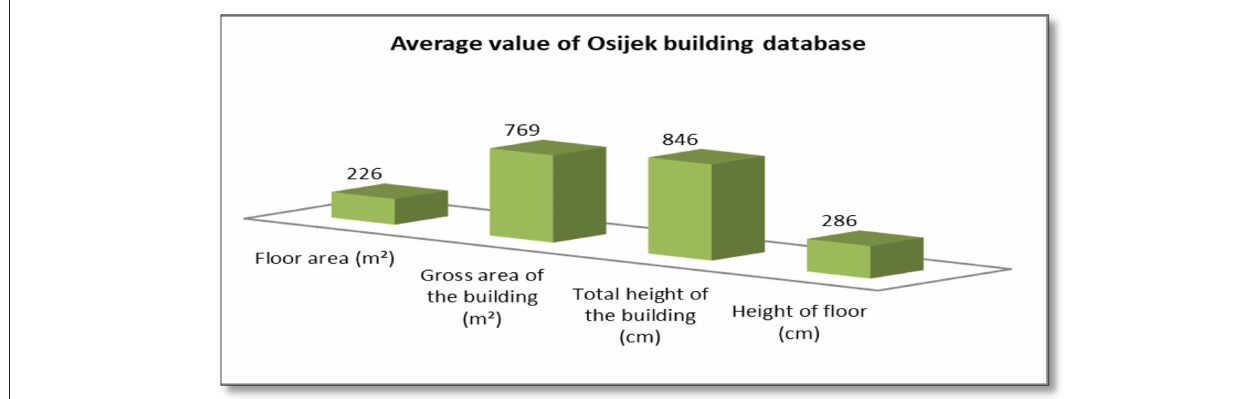
FIGURE 4 | Average values of Osijek building database.